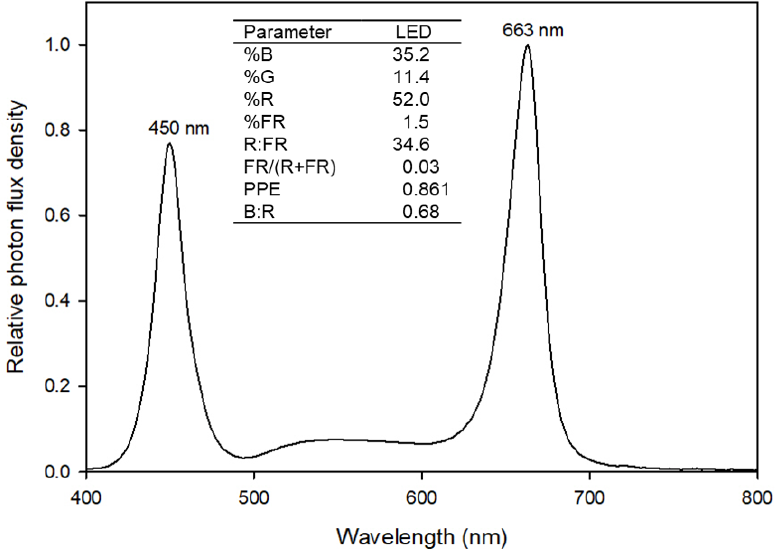
Figure 6. The spectral distribution of white + blue + red light-emitting diodes used for sole-source lighting treatments. The numbers above the peak of the spectral distribution indicate the peak wavelengths. The percentage (%) of blue (B, 400–500 nm), green (G, 500–600 nm), red (R, 600–700 nm), and far-red (FR, 700–800 nm) light were calculated as the ratio of the photon flux density integral of each waveband and total photon flux density (400–800 nm). R:FR was calculated as the ratio of the photon flux integral of R and FR light. FR fraction or ratio of photon flux integral of FR (700–800 nm) to the sum of the photon flux integral of R (600–700 nm) and FR was calculated following Kusuma and Bugbee [42]. Estimated phytochrome photoequilibria (PPE) was calculated following